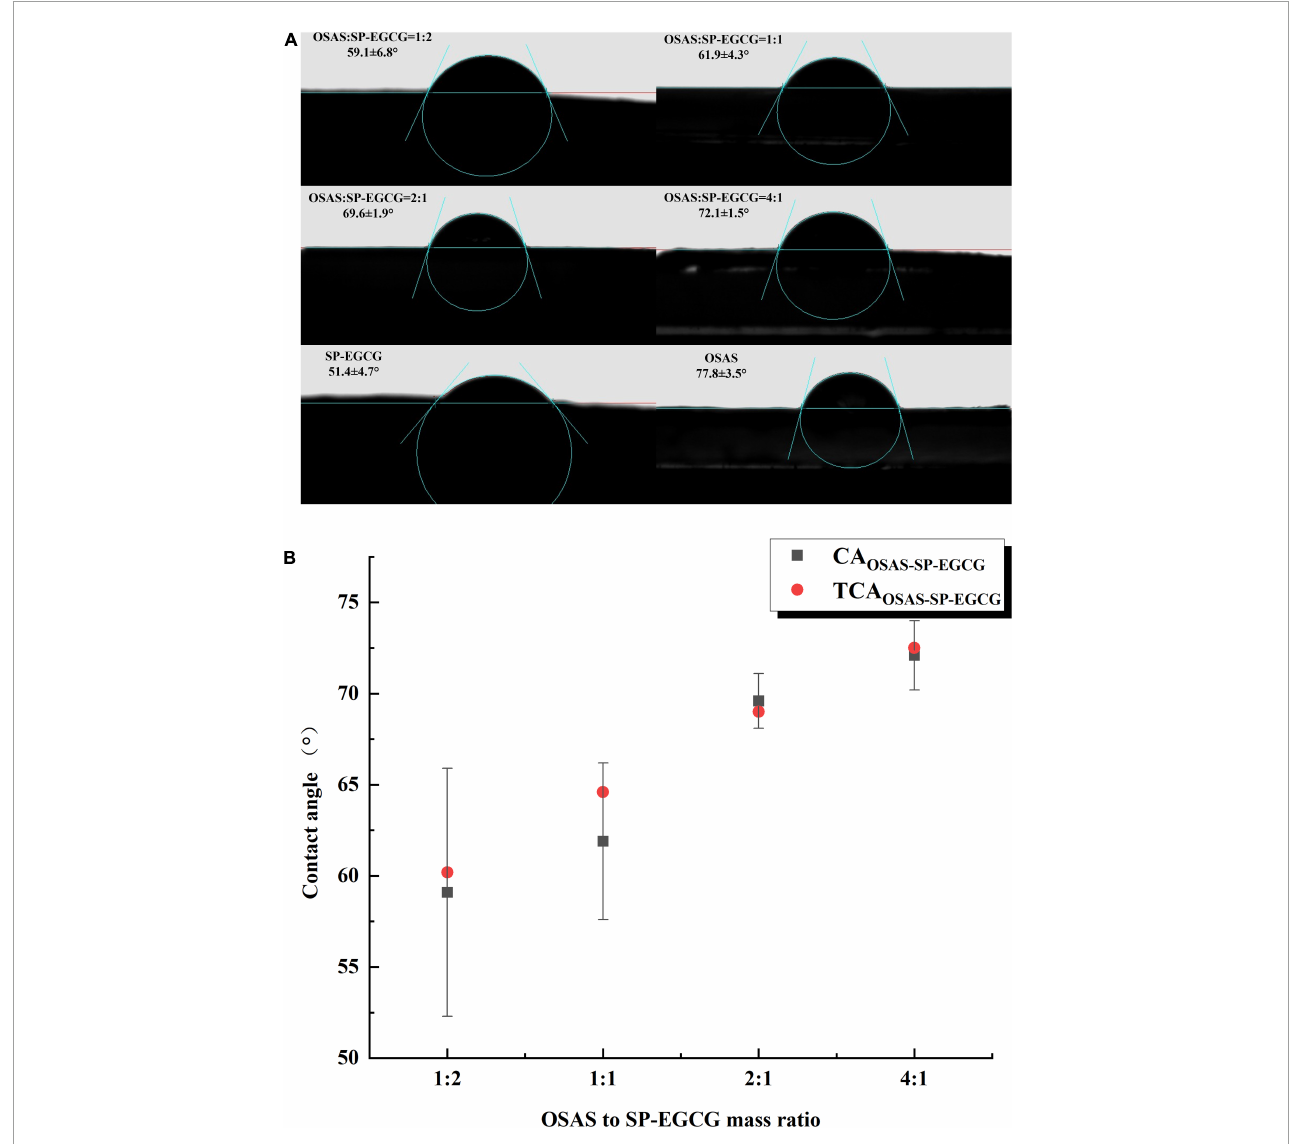
FIGURE5 Contact angle for OSAS, SP-EGCG, and OSAS-SP-EGCG complexes (A) and the relationship between the measured and theoretical contact angle values for OSAS-SP-EGCG complexes (B)